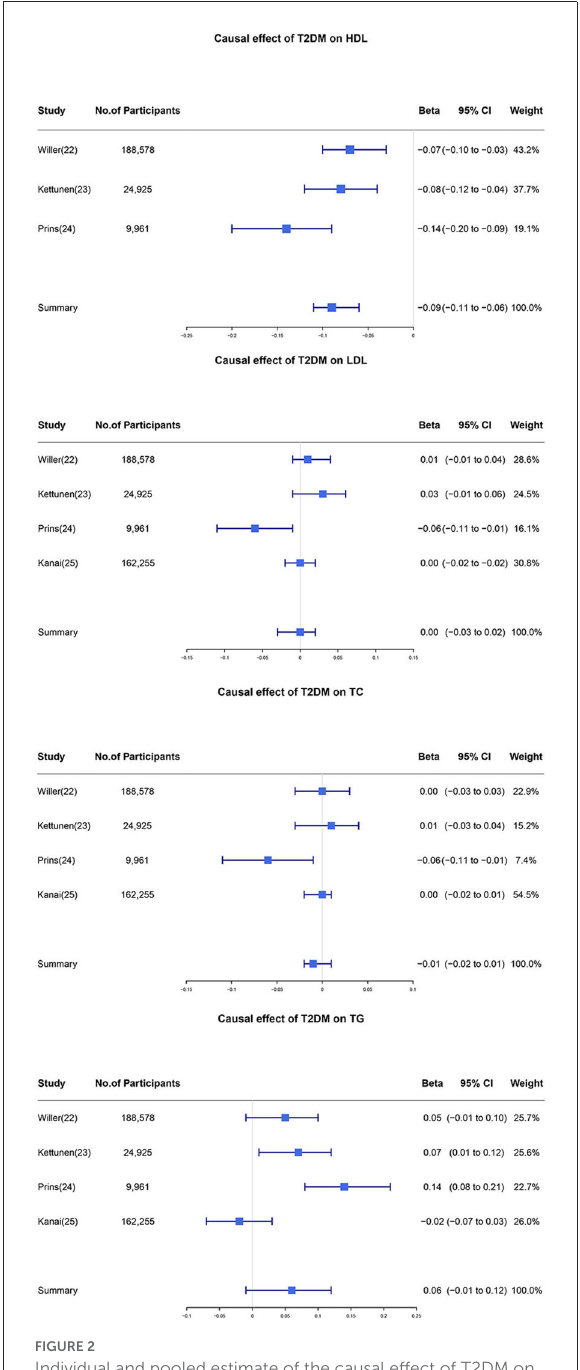
FIGURE2 Individual and pooled estimate of the causal effect of T2DM on each blood lipid profile. Firstly we applied the two-sample MR method to estimate the causal effect of T2DM on each blood lipid profile. Then these individual estimates were further meta-analyzed to obtain the pooled results. T2DM, type 2 diabetes mellitus; HDL, high-density lipoprotein; LDL, low-density lipoprotein; TC, total cholesterol; TG, triglycerides; CI, confidence